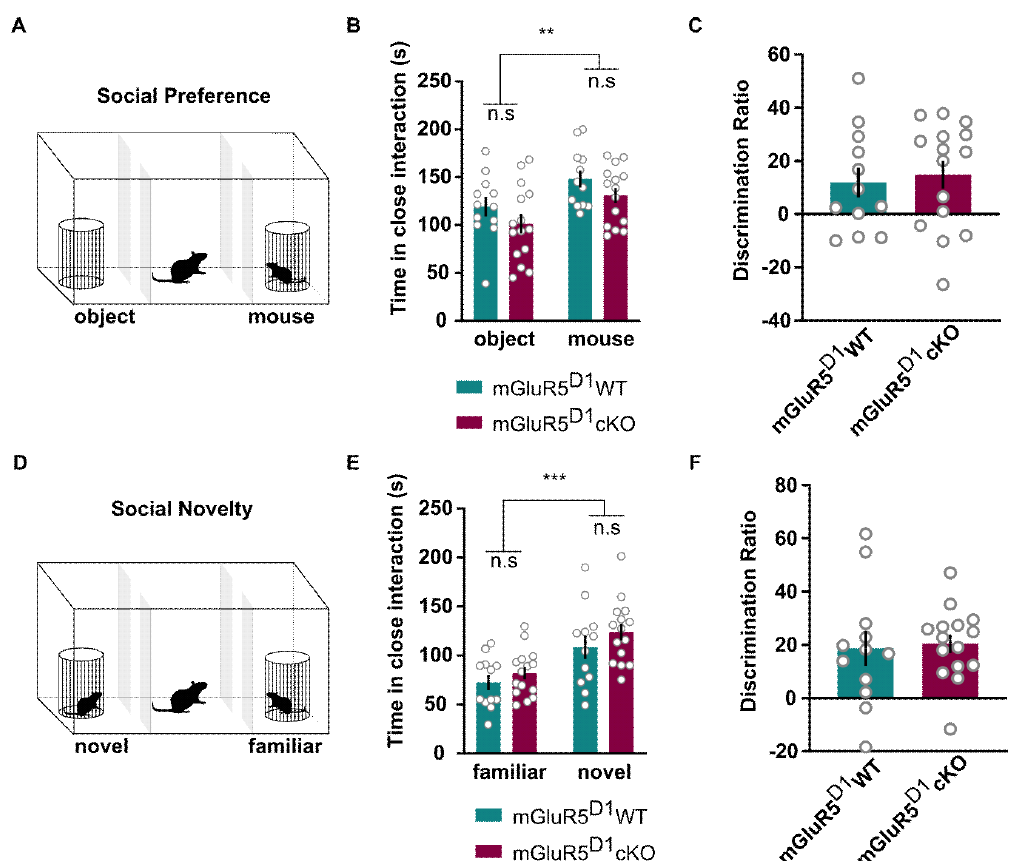
Figure 5. ( A ) Scheme of the social preference behavioral paradigm. ( B ) mGluR5 D1 WT and cKO mice showed similar social preference as measured with time spent interacting with the object vs the mouse (s): Two-way ANOVA, main effect genotype: F(1, 25) = 3.28, ns ( p = 0.08); main effect object/mouse: F(1, 25) = 10.86, p = 0.002; interaction effect: F(1, 25) = 0.003, ns ( p = 0.96). ( C ) mGluR5 D1 WT and cKO mice showed similar social preference, as measured with the discrimination ratio. Unpaired T-test, T = 0.38, ns ( p = 0.70). ( D ) Scheme of the social novelty paradigm. ( E ) mGluR5 D1 WT and cKO mice showed similar social novelty as measured with time spent interacting with the familiar vs the novel mouse (s): Two-way ANOVA, main effect genotype: F(1, 25) = 1.71, ns ( p = 0.20); main effect novel/familiar: F(1, 25) = 27.73, p = 0.001; interaction effect: F(1, 25) = 0.16, ns ( p = 0.69). ( F ) mGluR5 D1 WT and cKO mice showed similar social novelty, as measured with the discrimination ratio. Unpaired T-test, T = 0.26, ns ( p = 0.79); n = 12 mGluR5 D1 WT, n = 15 mGluR5 D1 cKO mice. ** p ≤ 0.01; *** p ≤